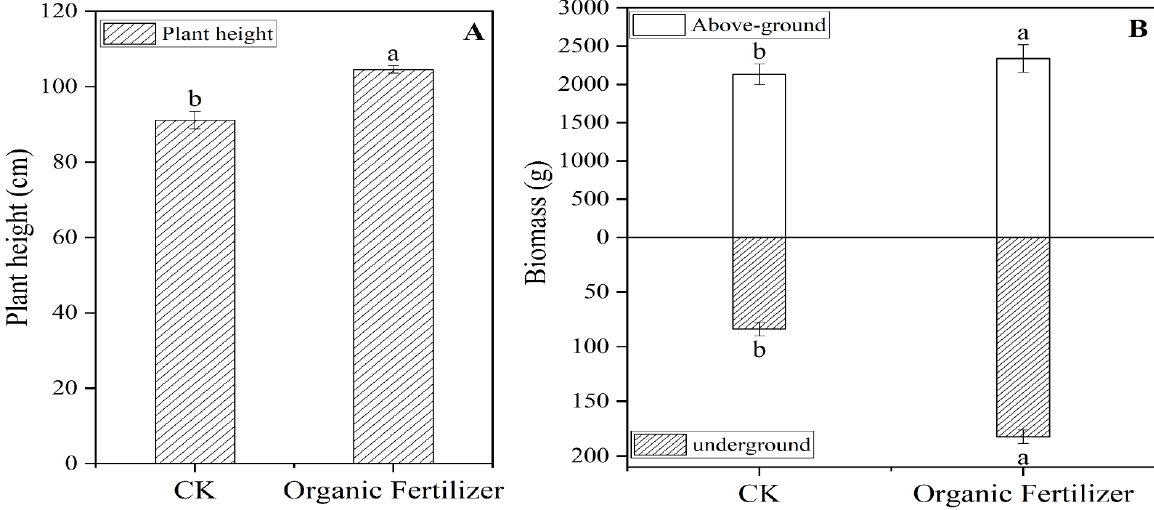
Figure 2. Elymus nutans ‘Aba’ plant height and biomass: ( A ) plant height; ( B ) biomass. Lowercase letters indicate statistically significant differences.